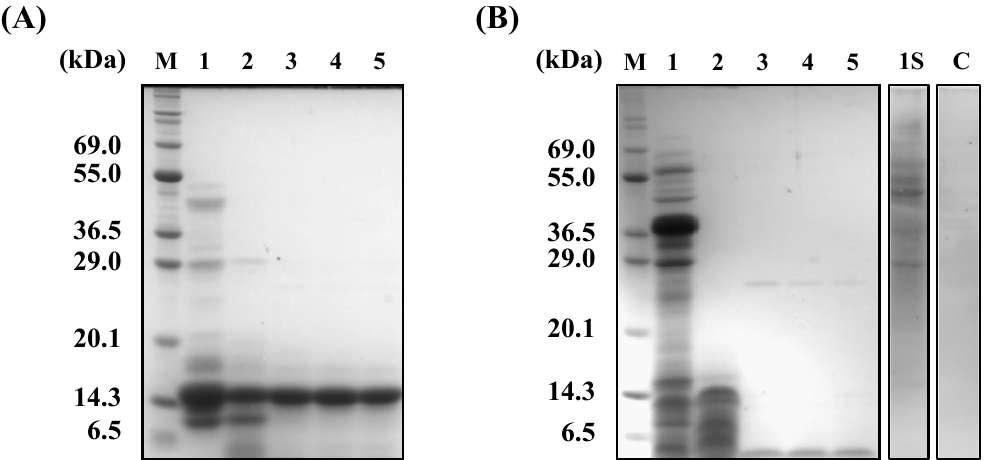
Figure 6. SDS-PAGE of wheat and buckwheat α -AIs before and after treatment with digestive enzymes and glycoprotein staining. ( A ) Wheat α -AI; ( B ) Buckwheat α -AI. (M) Marker; (1) Undigested; (2) Digested by pepsin for 2 h; (3) Digested by pepsin for 2 h followed by digestion with trypsin for 2 h; (4) Digested by pepsin for 2 h followed by digestion with trypsin for 4 h; and, (5) Digested by pepsin for 2 h followed by digestion with trypsin for 6 h; (1S) Undigested and stained with glycoprotein-staining reagent; (C) Bovine serum albumin stained with glycoprotein-staining